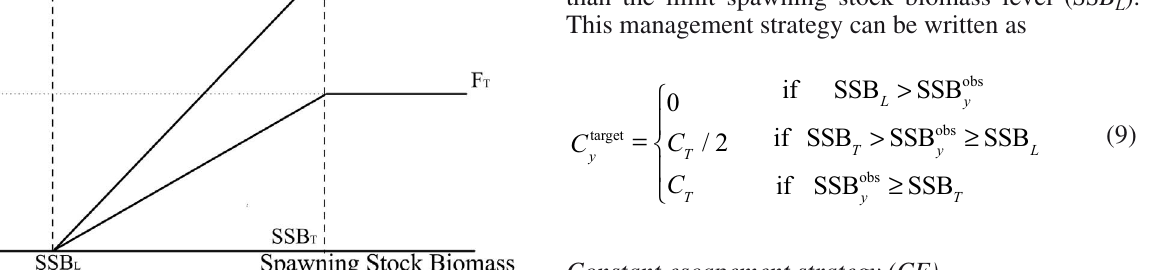
, limit fishing L , limit L